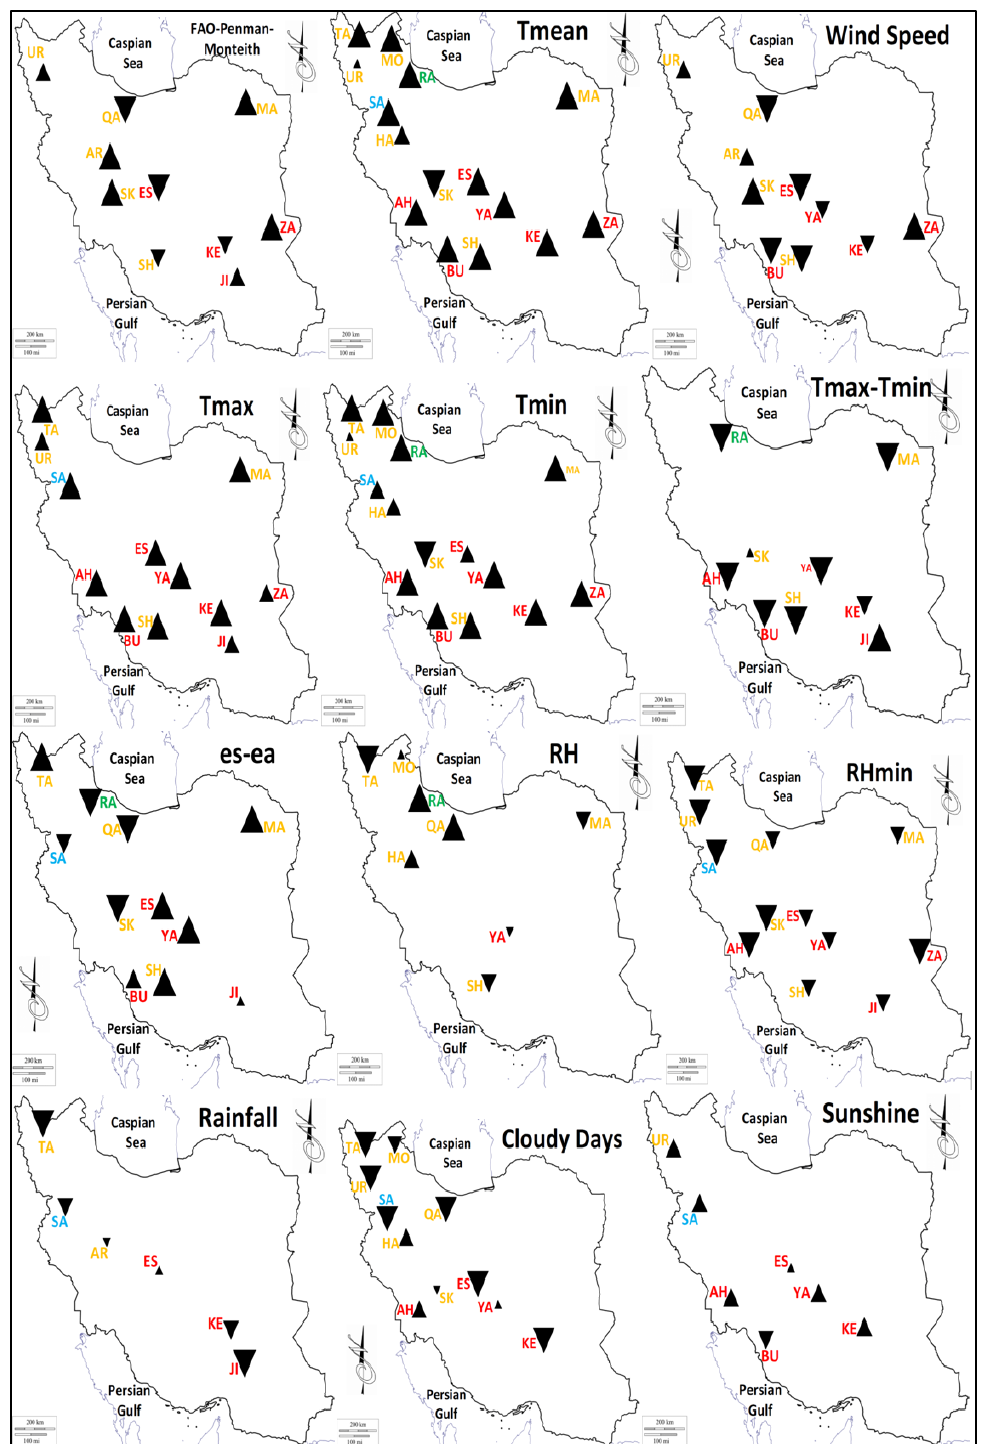
Figure 4. The average of variations in reference evapotranspiration and meteorological variables in Iran from 1961 to 2010. Big, medium, and small triangles imply significant values at a confidence level of 99%, 95%, and 90%, respectively. Blue, red, yellow, and green colors indicate Mediterranean, arid, semiarid and humid climates, respectively.